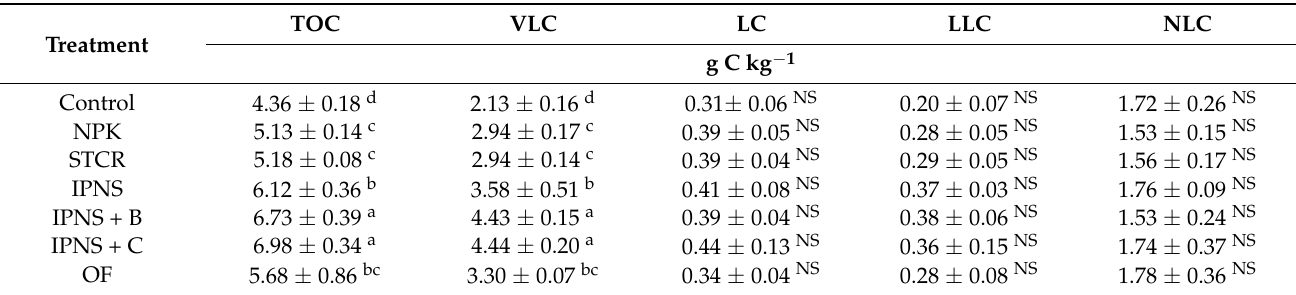
Table 2. Effect of nutrient management on soil C fractions (15–30 cm) under rice-wheat production system. Means ± standard deviation of different treatments followed by the different lower-case letter (a–d) are significantly different at p < 0.05 level of significance according to DMRT, NS—non